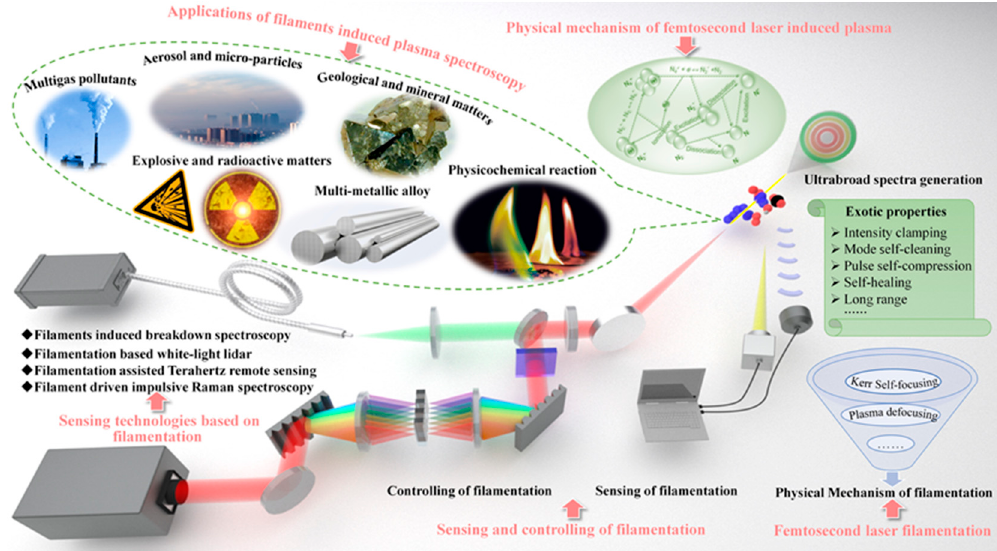
Figure 1. Overview of the recent progress in sensing with femtosecond laser filamentation.